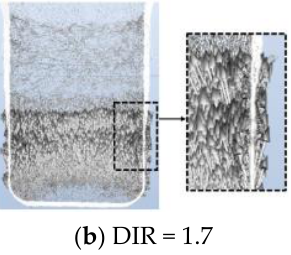
Figure 11. Principal stress in the axial direction.